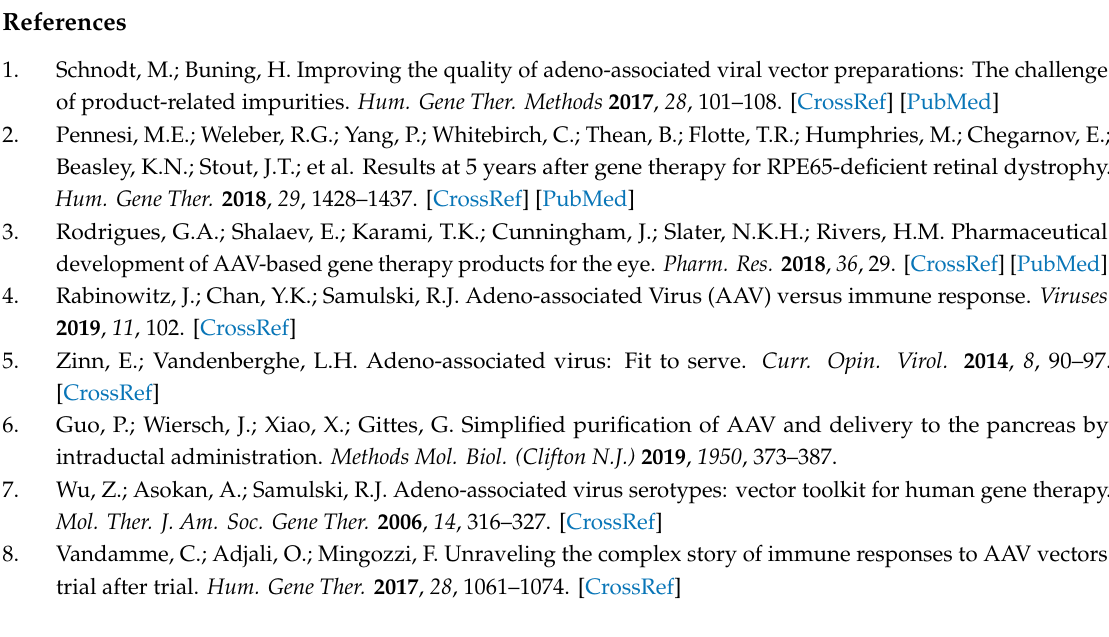
Table S1: Amino acid sequences of AAVR (PKD1-5) and SBP tag with the primers used for the construction of PET28a-AAVR-SBP-His